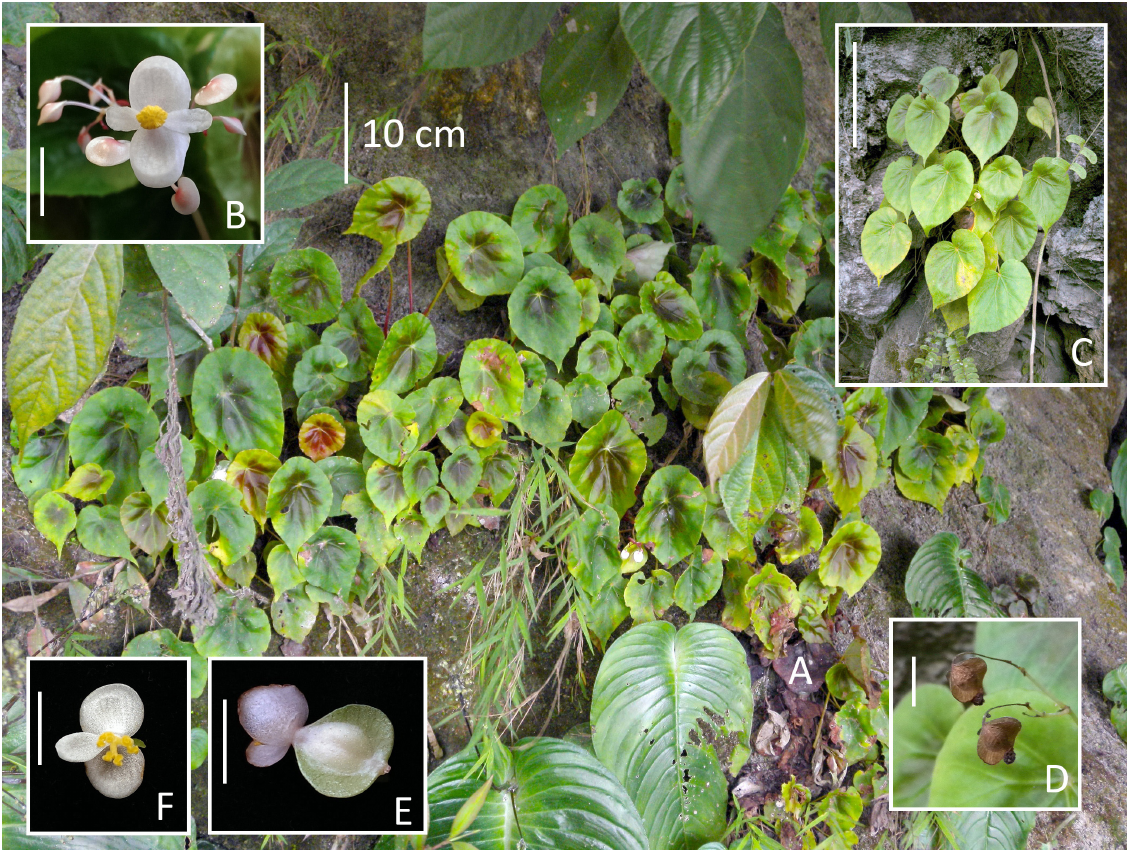
Fig. 8. Begonia karangputihensis Girm. sp. nov. A . Habit. B . Male flower. C . Plant with young leaves showing transition from basifixed to peltate. D . Mature fruit on a recurved pedicel. E . Ovary. F . Female flower. A,C, D taken at the type locality of Bukit Karang Putih; the floral insets B, E, F were photographed from plants in cultivation at the Royal Botanic Garden Edinburgh, accession 20111545. Scale bars on insets: B, D–F = 1 cm; C = 10